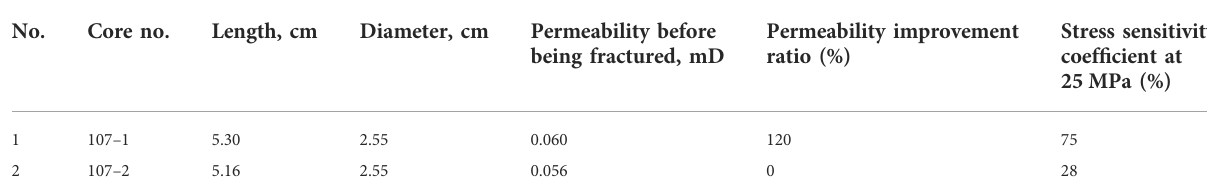
TABLE 5 Rock properties of the stress sensitivity test.